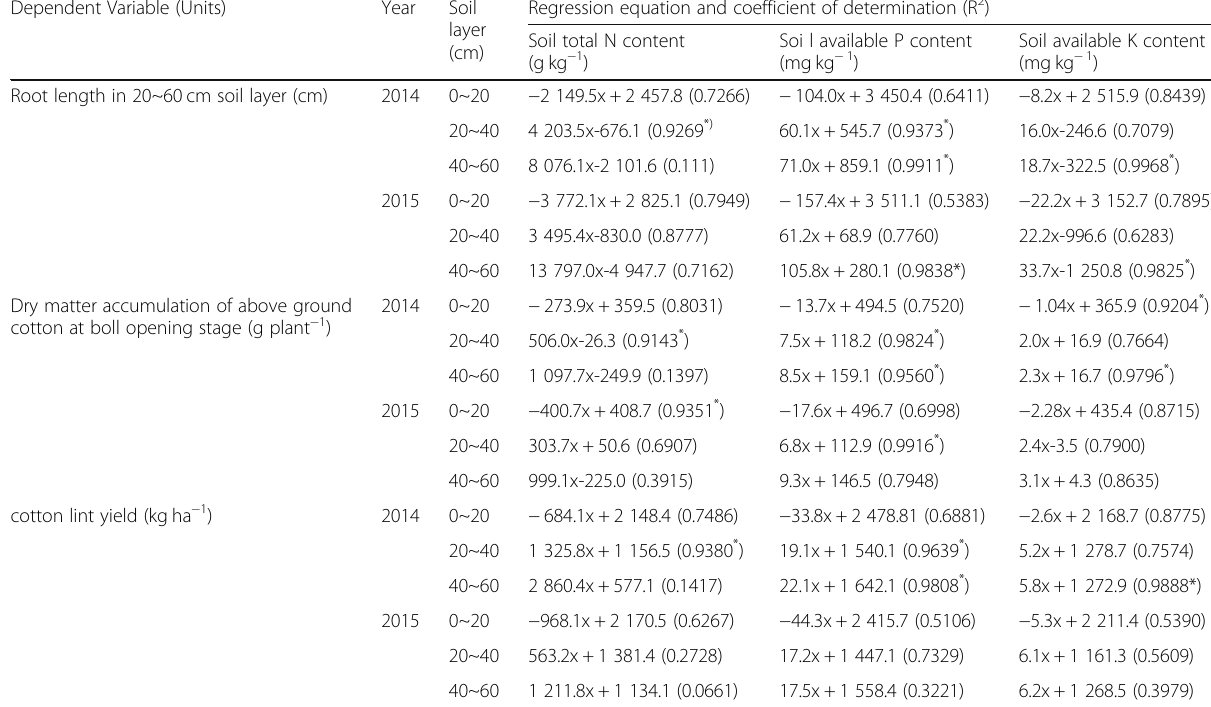
Table 5 Relationship of cotton root length in the 20~60 cm soil layer, dry matter accumulation of above-ground cotton at the boll opening stage and cotton lint yield to soil total N, available P, available K content in different soil layers in 2014 and 2015 Dependent Variable (Units)